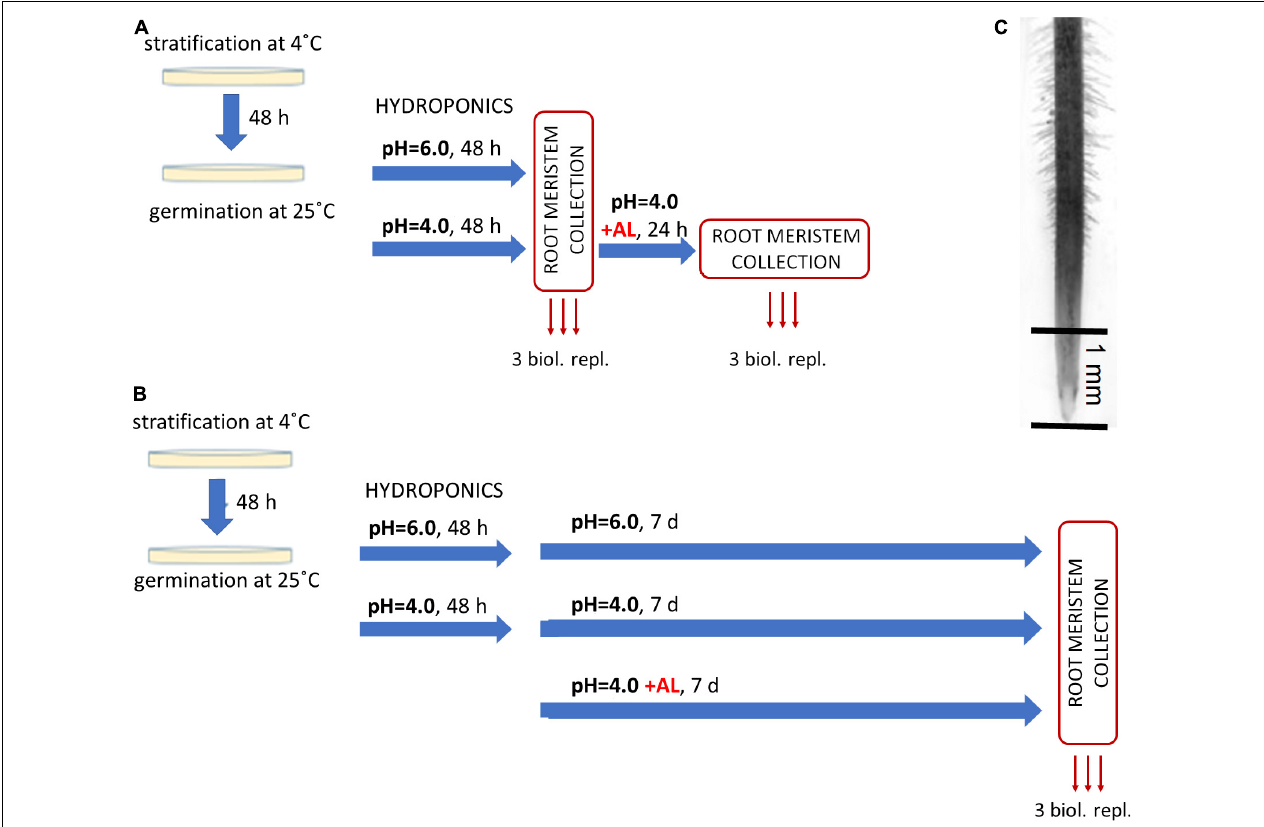
FIGURE 1 | Experimental setup for RNA-Seq analysis. After 48 h of germination on Petri dishes barley seedlings were transferred to hydroponics with Magnavaca medium adjusted to pH = 6.0 or pH = 4.0. After another 48 h AlCl 3 was added to the medium (10 µ M of bioavailable Al 3 + ions). (A) Short-term Al treatment. Root meristems were taken for RNA isolation just before Al addition (as control at pH = 6.0 and pH = 4.0) and after 24 h of Al treatment. (B) Long-term Al treatment. Root meristems were taken for RNA isolation from seedlings 7 days after Al addition and from seedlings grown at pH = 6.0 and pH = 4.0 without Al at the same time point. (C) The picture of barley root with an indication of its part (root meristem, ∼ 1 mm of root tip) that was taken for RNA